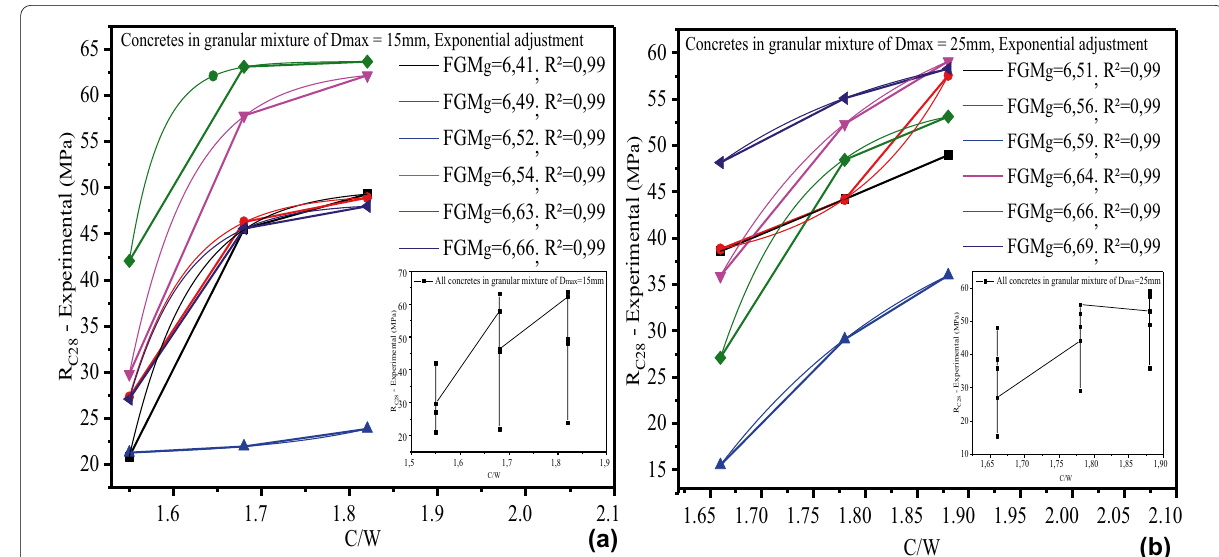
Fig. 19 Exponential adjustment of the experimental results using the models FGM g and FGM C . a Results relating to D 15 concrete, b results relating to D 25